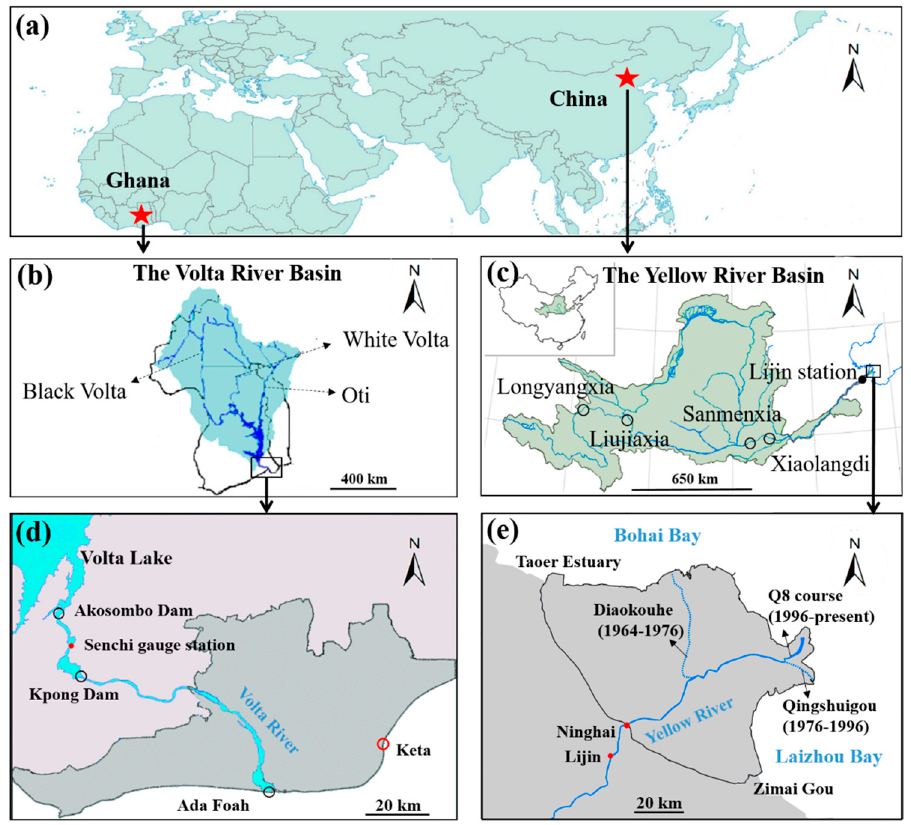
Figure 1. The study area: ( a ) The locations of Ghana and China, ( b ) the Volta River Basin, ( c ) the Yellow River Basin, ( d ) the Volta River Delta, and ( e ) the Yellow River Delta. The enclosed areas in ( d , e ) represent the extent of the two deltas.